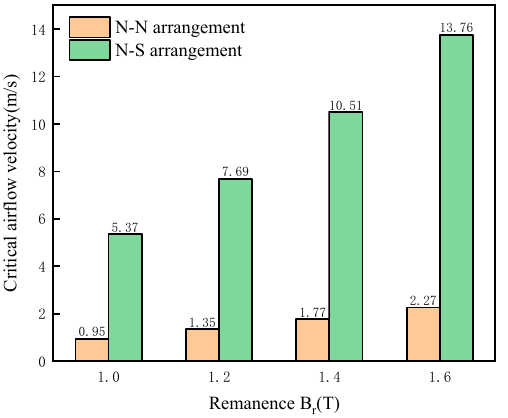
Figure 16. Change of magnetic particle (d = 23 𝜇 m) capture probability with airflow velocity in N- S arrangement.